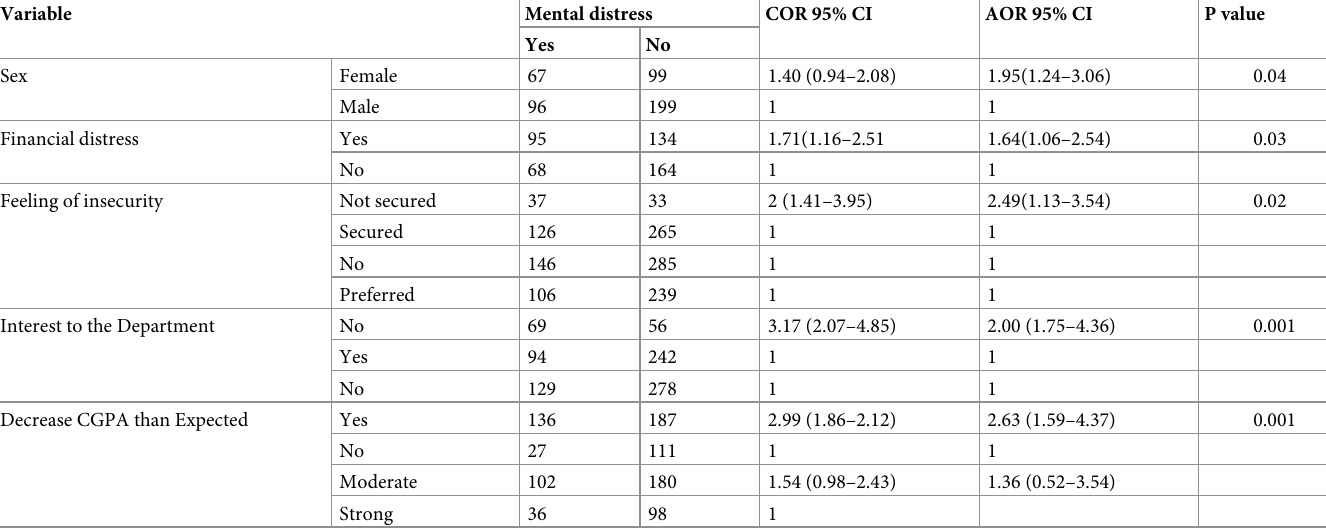
Table 3. Bivariable and multivariable logistic regression analysis of factors associated with mental distress those statically associated among DMU SMCHS students on mental distress, North West, Ethiopia, 2021(N = 461). Variable